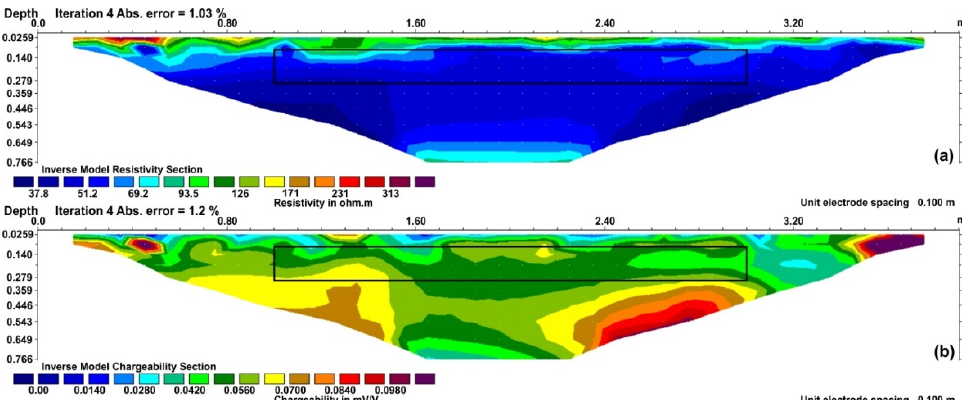
Figure 3. ( a ) Electrical resistivity section (color scale values in ohm.m) and ( b ) normalized charge- ability section (color scale values in mV/V) from site #33, acquired during the wet period. The black rectangle on the sections indicates the effective area of data used to evaluate the mean, median and average values from each section.